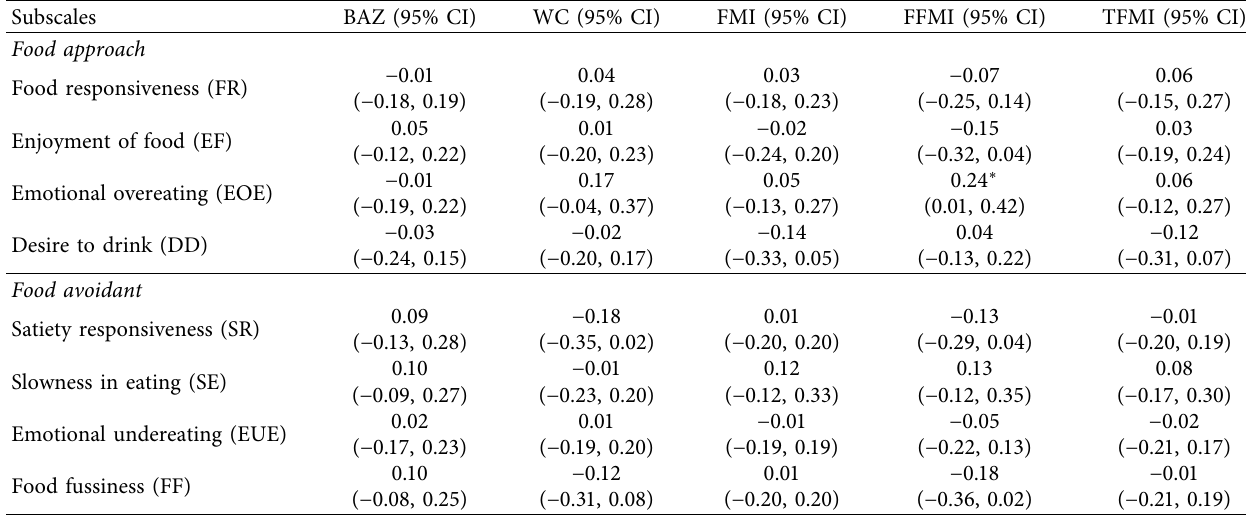
Table 2: Correlations between CEBQ subscales and variables ( n �